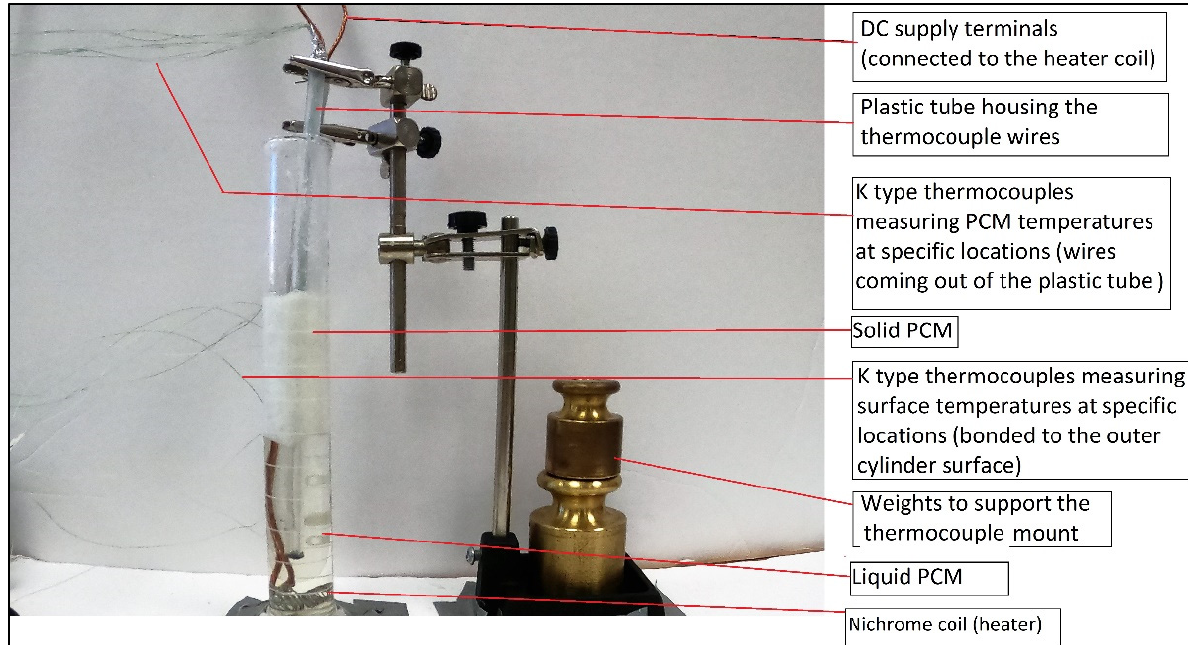
Figure 1. Photograph of the experimental apparatus used in this study.